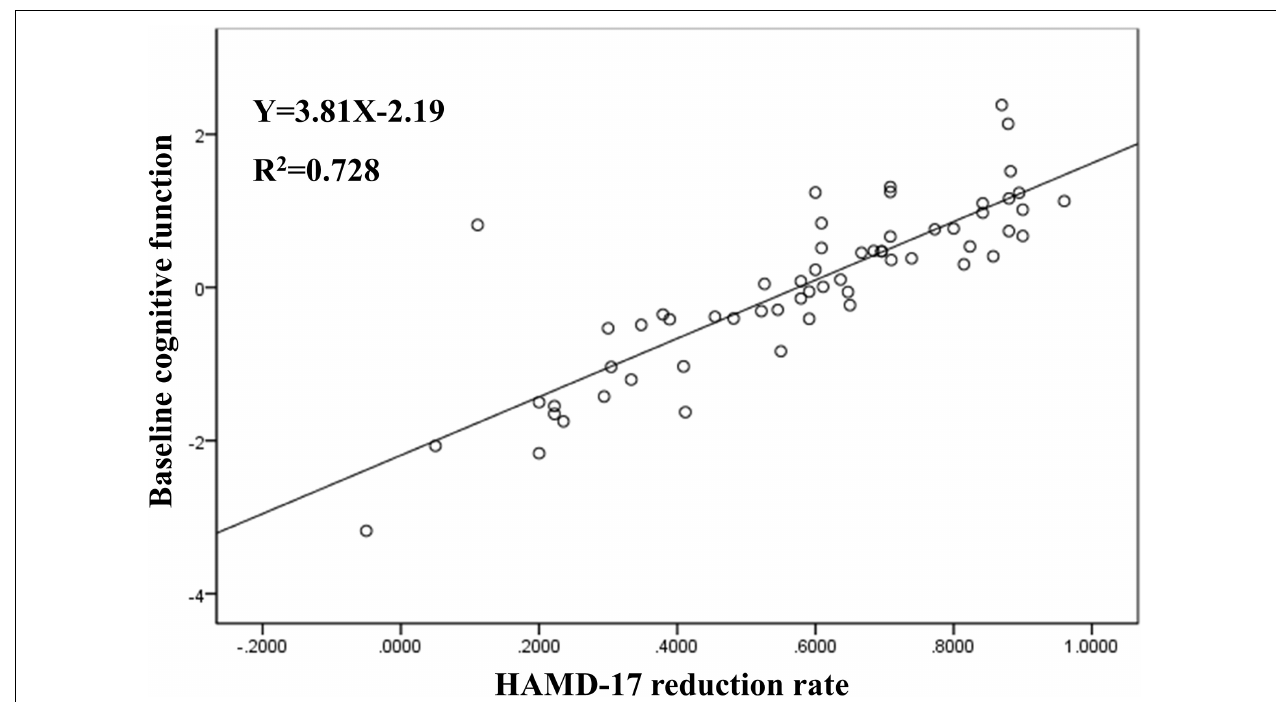
FIGURE 1 | Predictors of the cognitive function on HAMD-17 reduction rate in